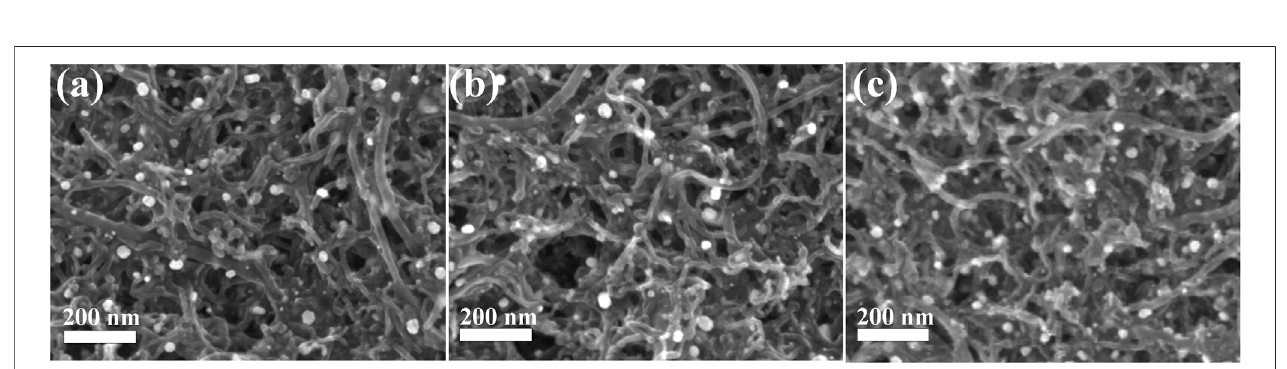
FIGURE 4 | FESEM images of (A) Pt/MoC 0.05 /MWCNTs, (B) Pt/MoC 0.15 /MWCNTs and (C) Pt/MoC 0.25 /MWCNTs.